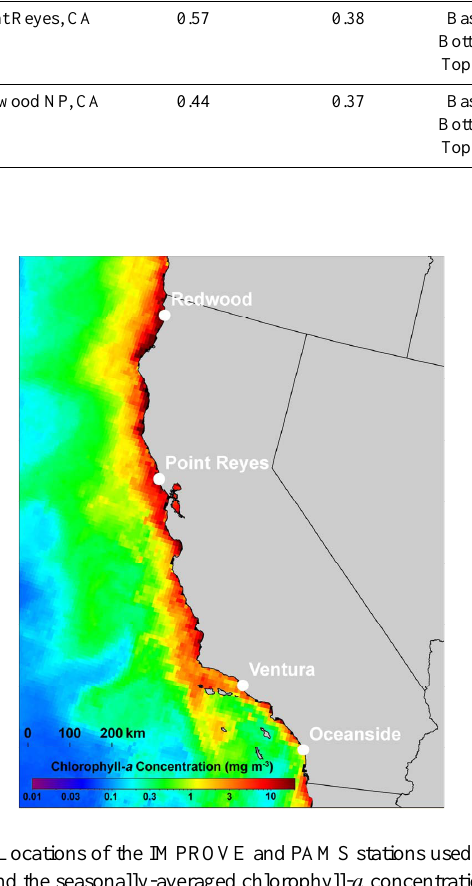
into sea spray emissions by calculating the apparent density of the sea spray aerosol as a function of organic fraction. In the model results, the sum of the Aitken and accumulation mode constitutes particles with an aerodynamic diameter less than 2.5 µm. For model-predicted changes in OC 2 . 5 concen- trations due to marine organics, an OM/OC mass ratio of 1.4 is used for marine primary organic aerosols (Decesari et al.,